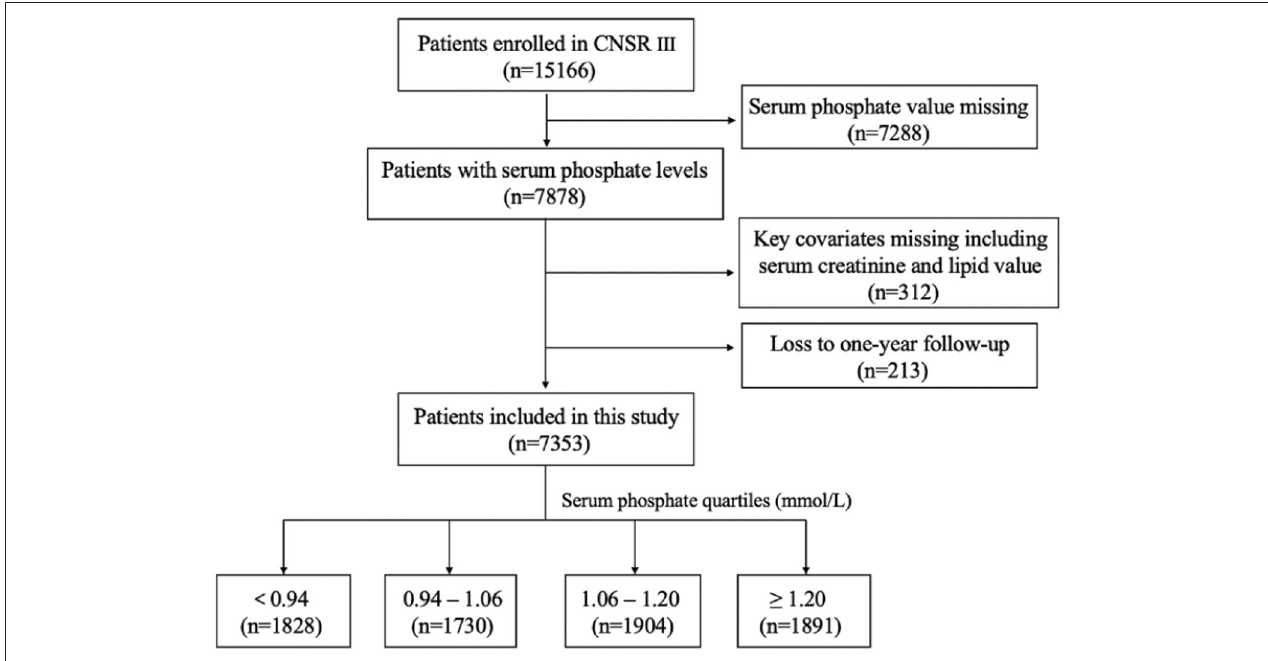
FIGURE 1 | Patient flow diagram. CNSR III, China National Stroke Registry III.